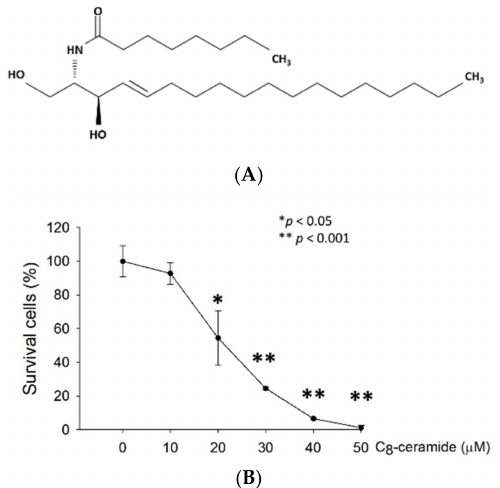
Figure 1. ( A ) Structure of the C 8 -ceramide ( N -octanoyl- D -erythro-sphingosine). ( B ) The quantitative analysis of cell proliferation assay showed the inhibition of growth in a dose-dependent manner (* p < 0.05, ** p < 0.001 for C 8 -ceramide treatment versus respective control).